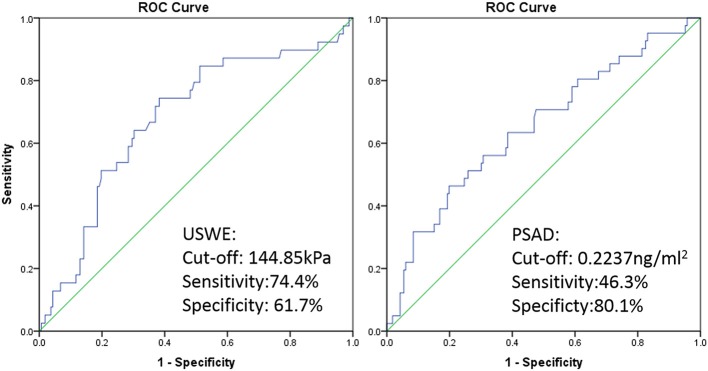
ROC curve of USWE (left) and PSAD (right) for differentiating BCR and BCR free of PCa after radical surgery.